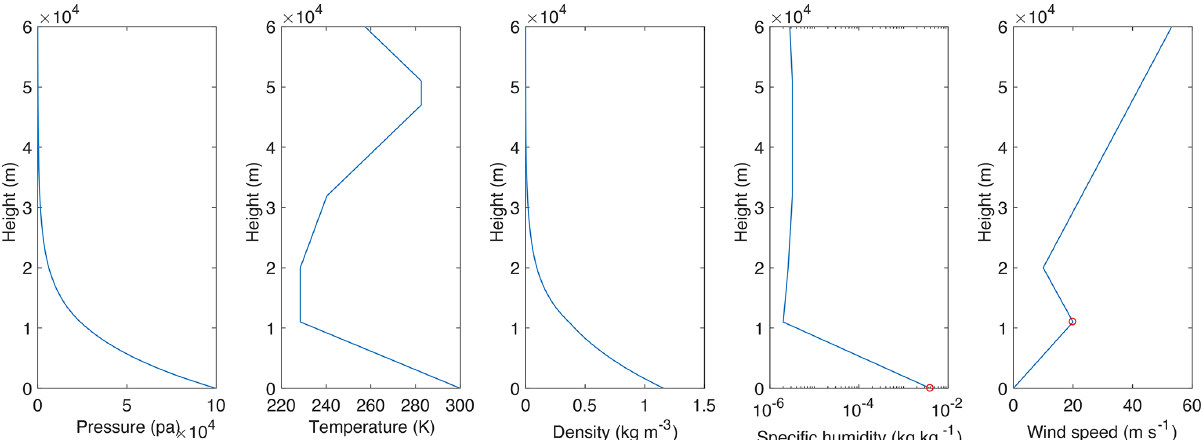
Figure 10. Atmospheric profiles for a dry atmosphere with a 20ms − 1 wind speed at the tropopause (11kma.s.l.). The red markers denote the values that can be changed in the modified standard atmosphere adopted in the model. The first three profiles (pressure, temperature, and density) also change when the specific humidity at the sea level is changed.